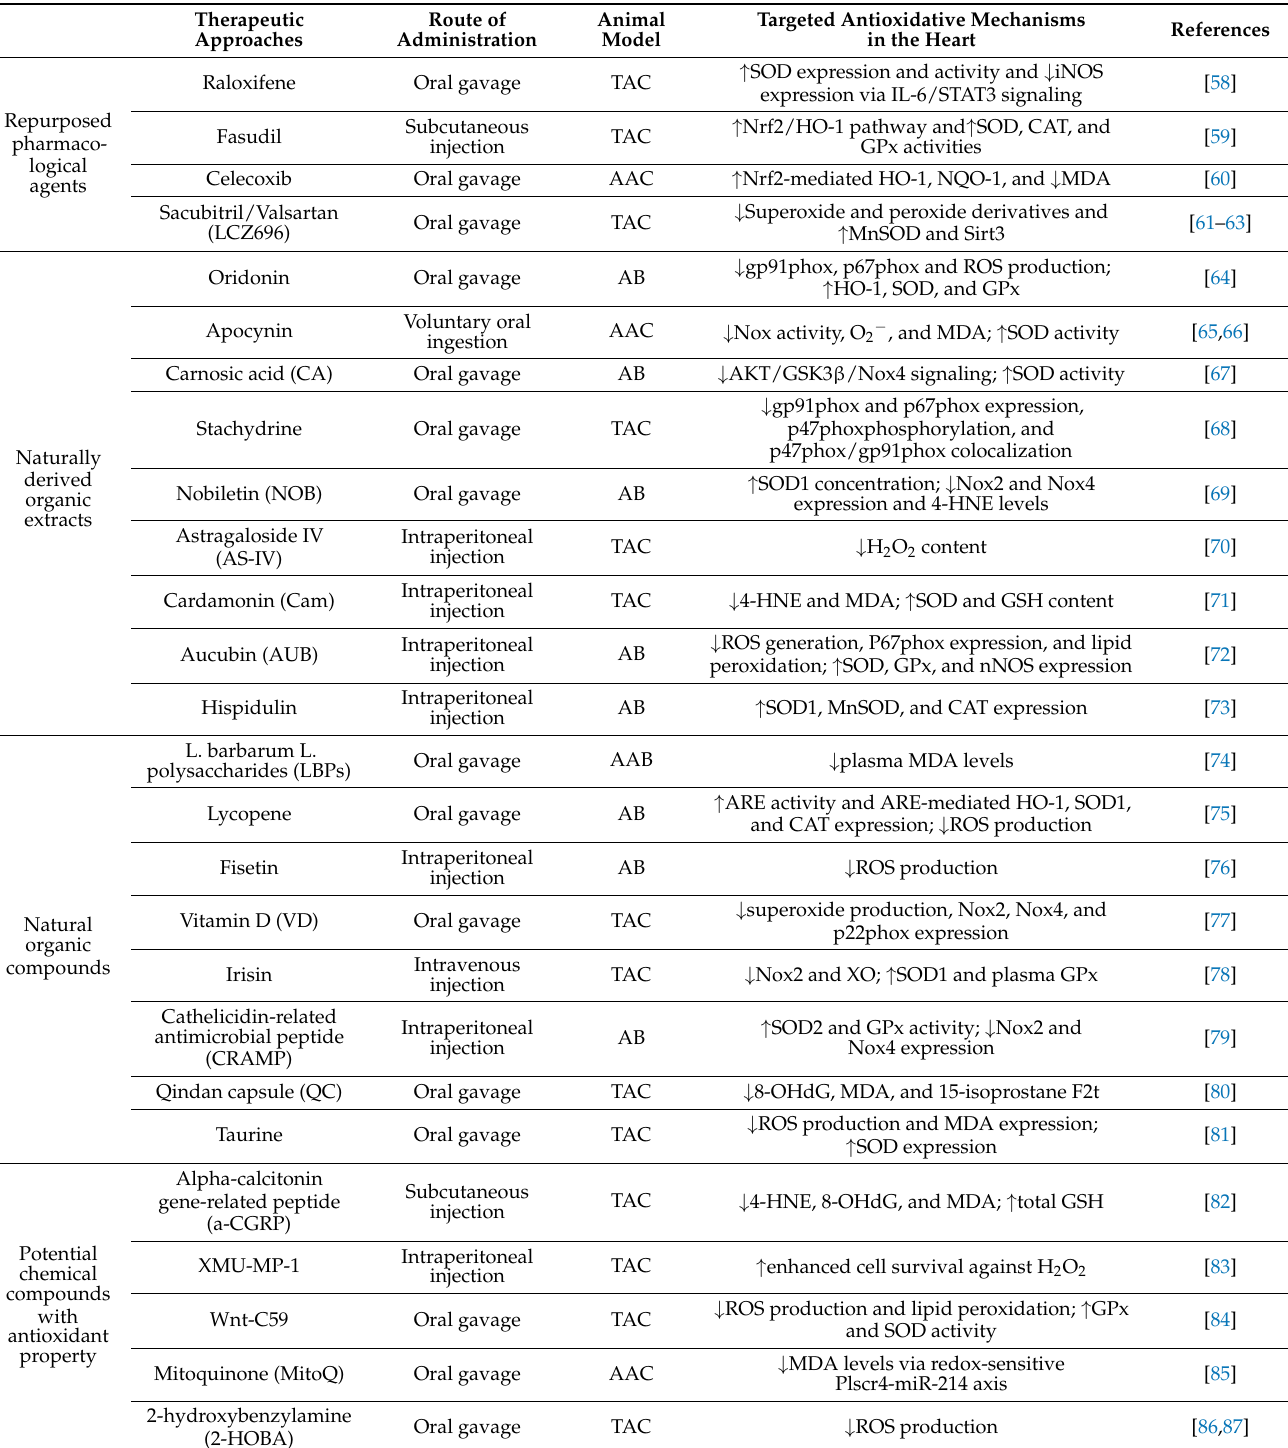
Table 1. The newly developed therapeutic approaches against cardiac pressure